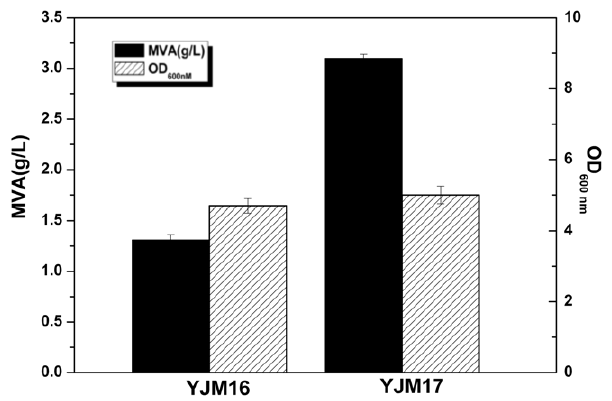
Figure 4. MVA production by strains with or without mutation of mvaS gene. The MVA isolated from cultural broth as described in ‘‘MVA quantification by gas chromatography (GC)’’. The experiment was performed in triplicate.